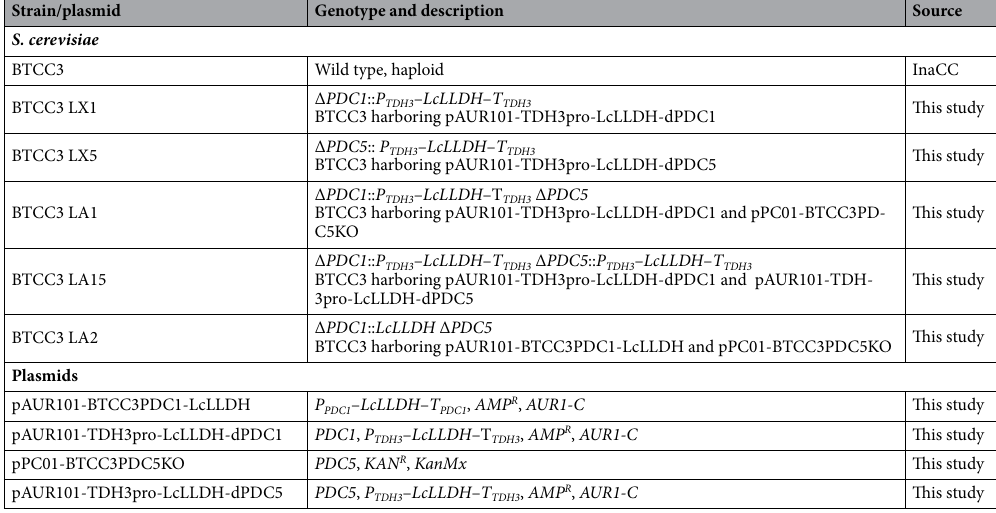
Table 1. List of strains and plasmids used in this